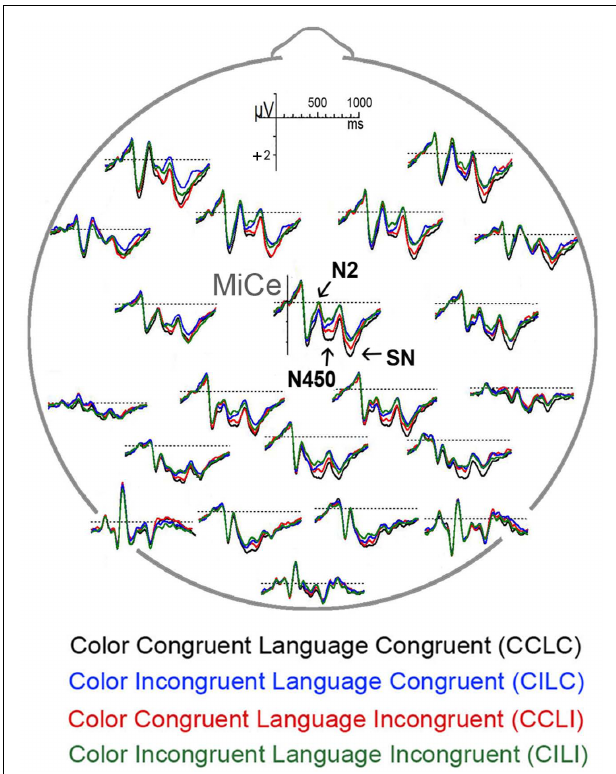
FIGURE 5 |A bird’s eye view of the geodesic electrode array showing grand average ERPs. Voltage is plotted in microvolts on the y -axis with negative up; time is plotted in milliseconds on the x -axis with 0ms marking the onset of the visually presented words and 100ms tick marks.